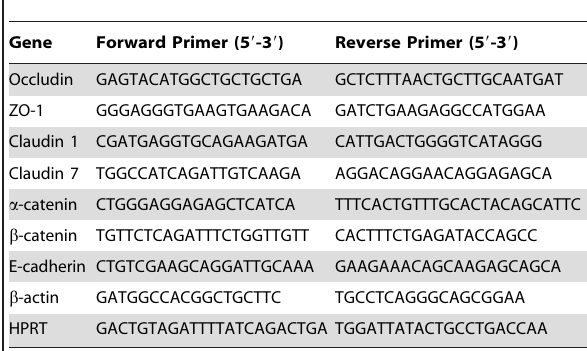
Table 1. Real-time PCR primer